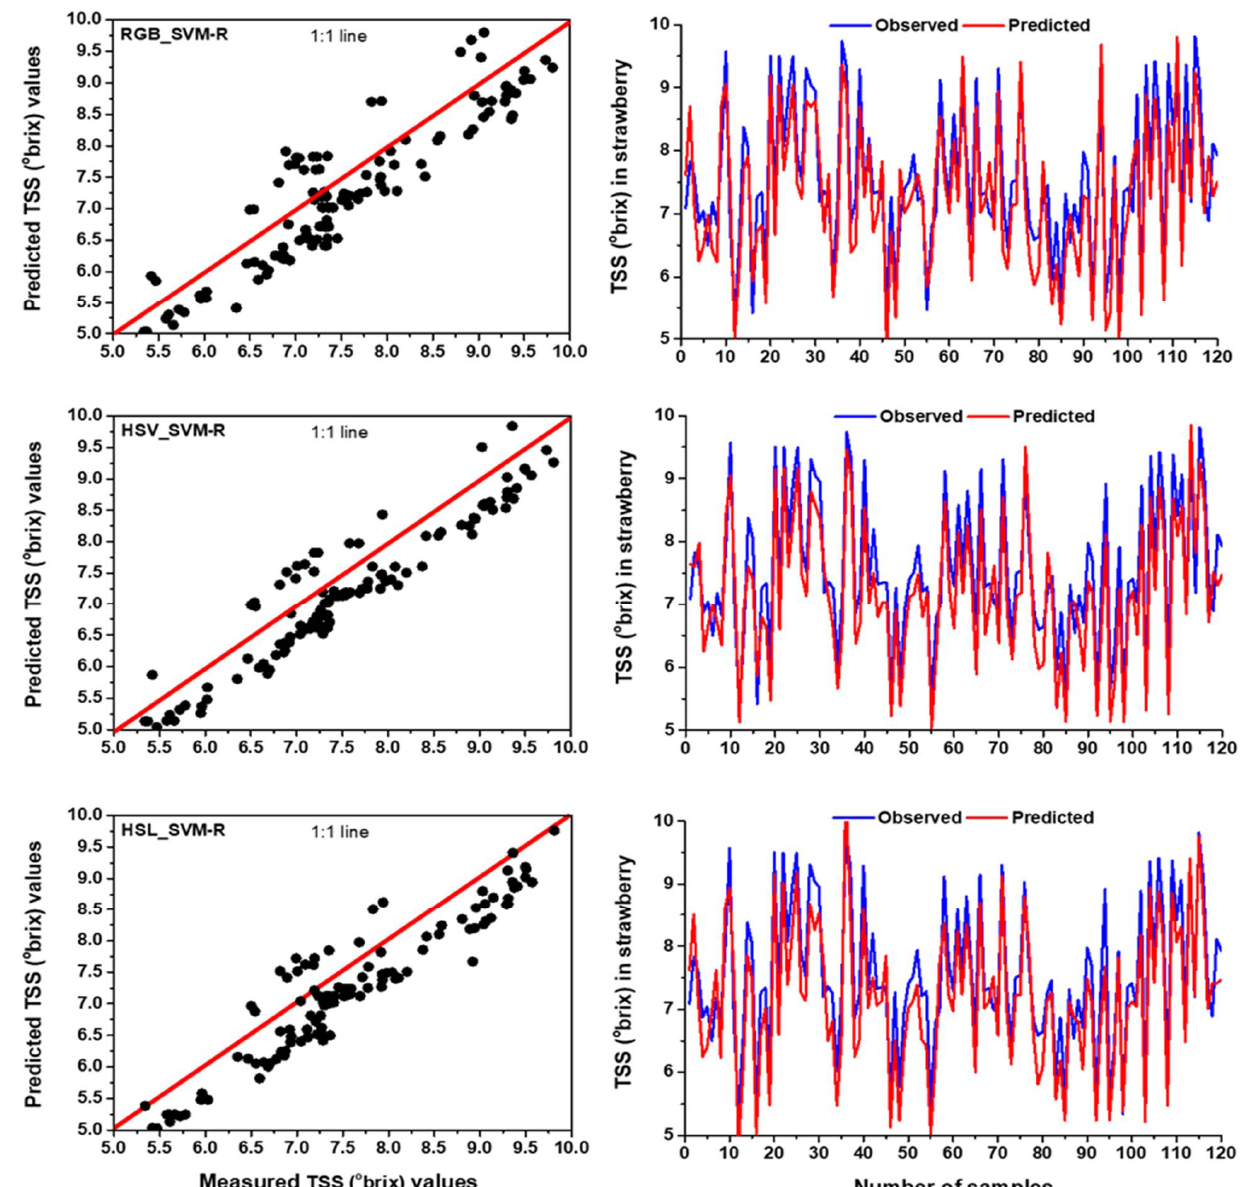
Figure 8. The comparison results between measured and predicted values by SVM-R model with RGB, HSV and HSL colour spaces for TSS prediction in the testing period using time series and scatter plots with 1:1 line.